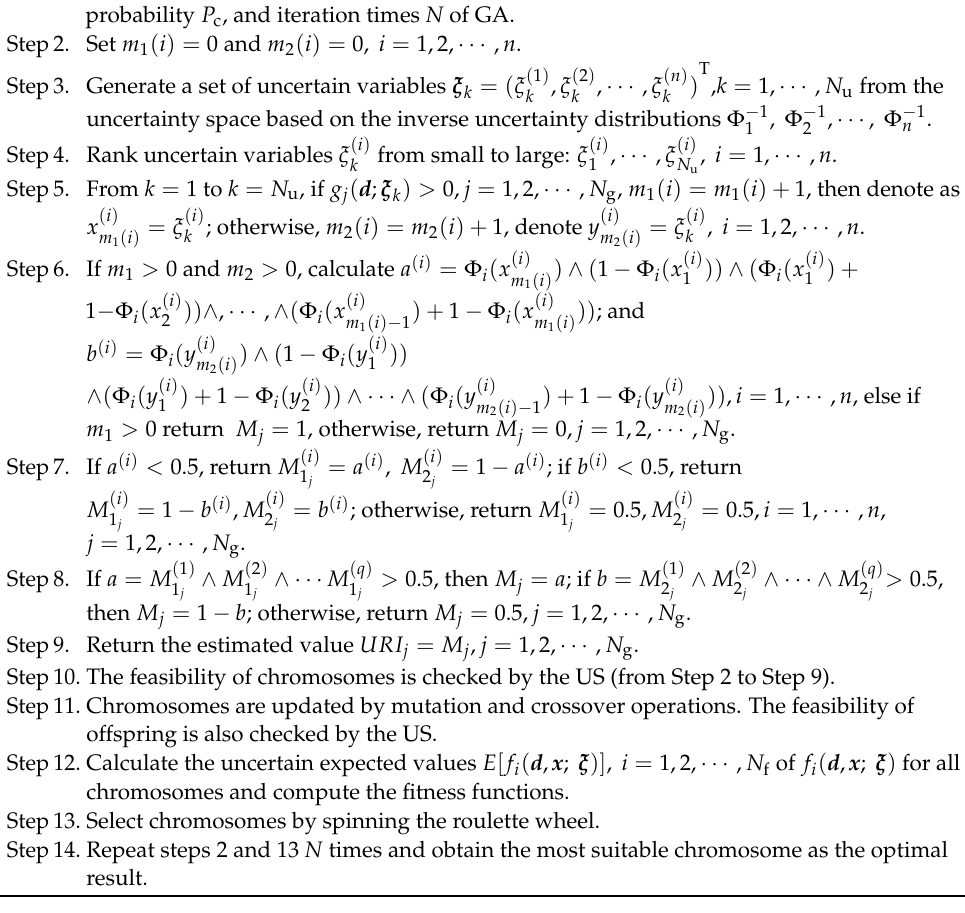
Algorithm 2. USGA for solving the URBDO